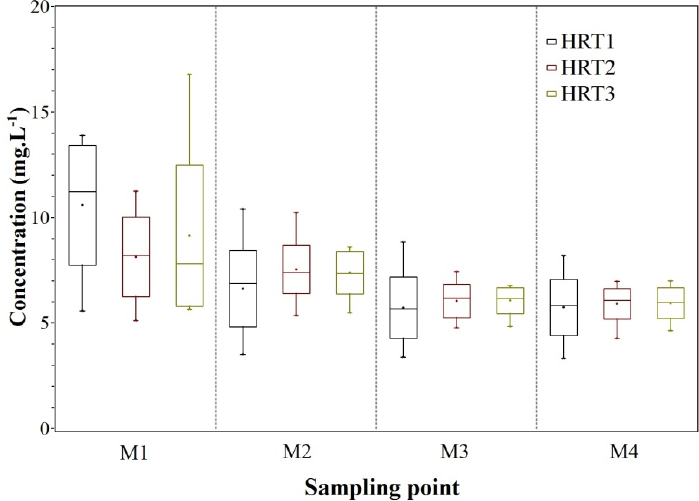
Figure 5. Plot of P tot (mg·L − 1 ), with maximum and minimum values and